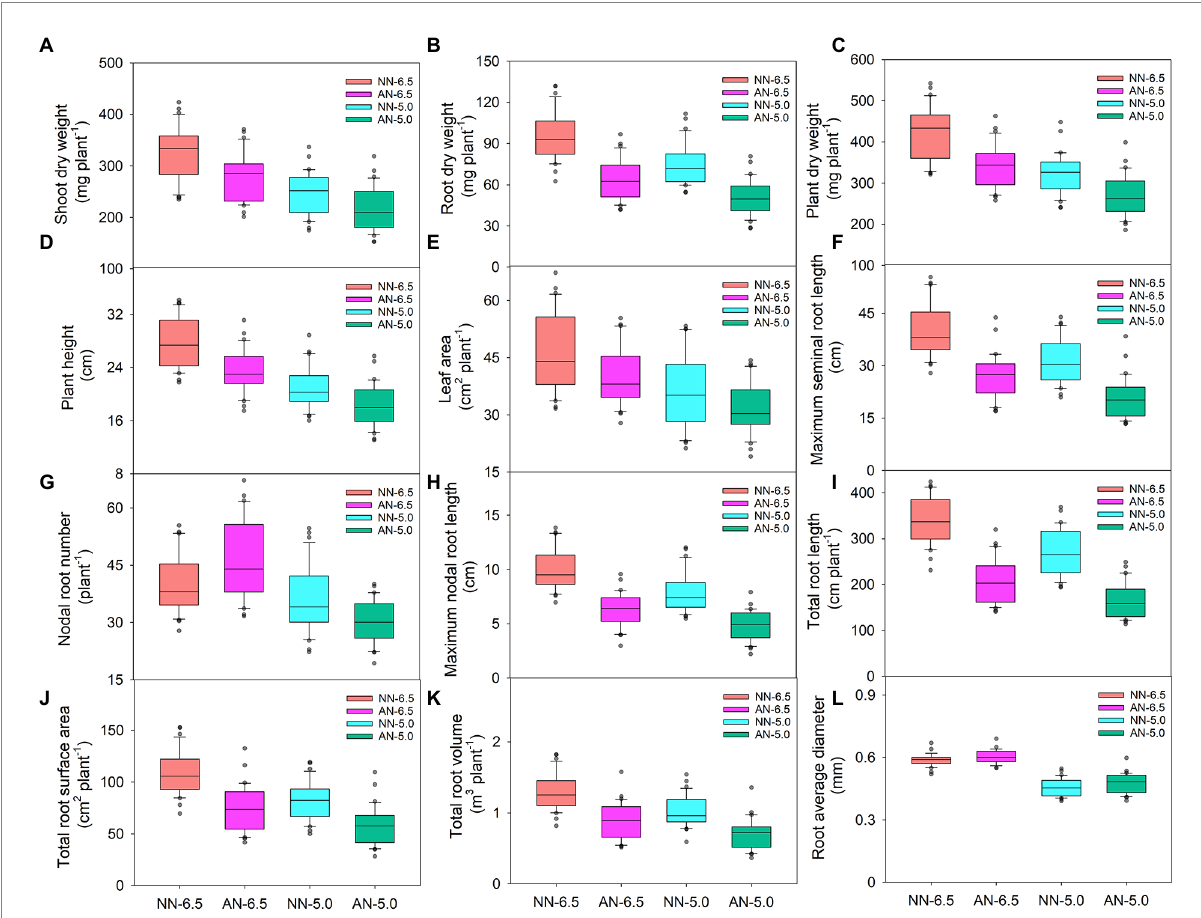
FIGURE 1 Biomass allocation, plant height, leaf area and root morphology of 31 wheat cultivars grown under different N-sources and pH levels. Data are means ± SE (n = 31). NN-6.5 refers to the nitrate nitrogen at a pH of 6.5; NN-4.5 refers to the nitrate nitrogen at a pH of 6.5; AN-6.5 refers to the ammonium nitrogen at a pH of 6.5; AN-5.0 refers to the ammonium nitrogen at a pH of